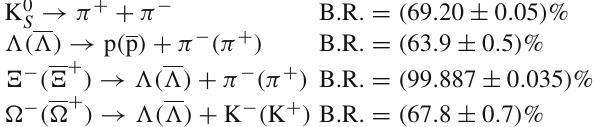
Table 2 Track, topological and Toplogical candidate selection criteria applied to K 0 , (cid:3) and (cid:3) S candidates. DCA stands for “distance of closest approach”, PV represents the “primary event vertex” and θ is the angle between the momentum vector of the reconstructed V 0 and the displacement vector between the decay and primary vertices. The selection on DCA between V 0 daughter tracks takes into account the corresponding experimental resolution